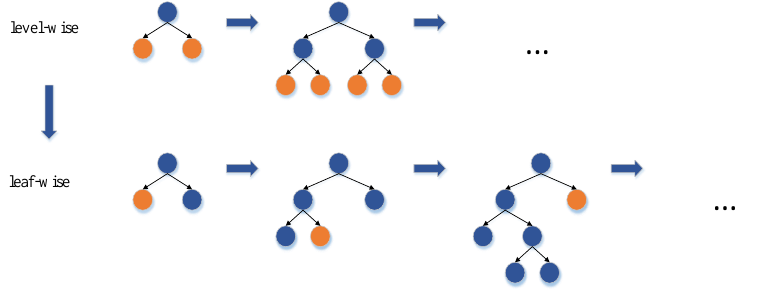
Figure 7. Level-wise and leaf-wise.